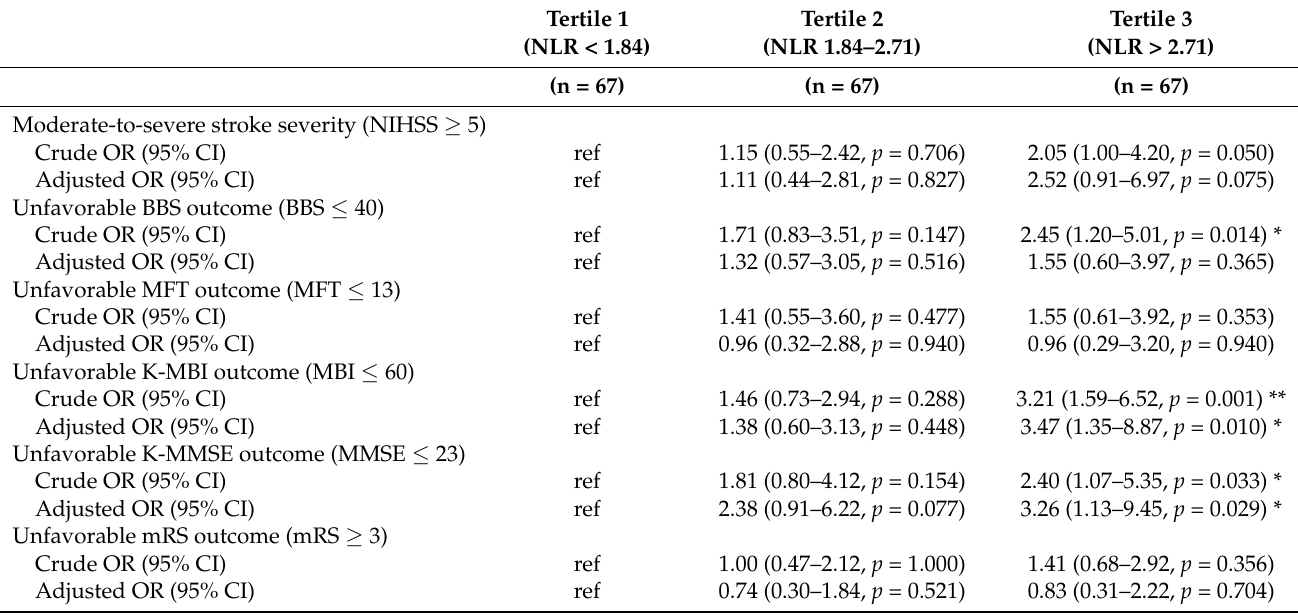
Table 2. Risks of stroke severity and functional outcomes according to NLR